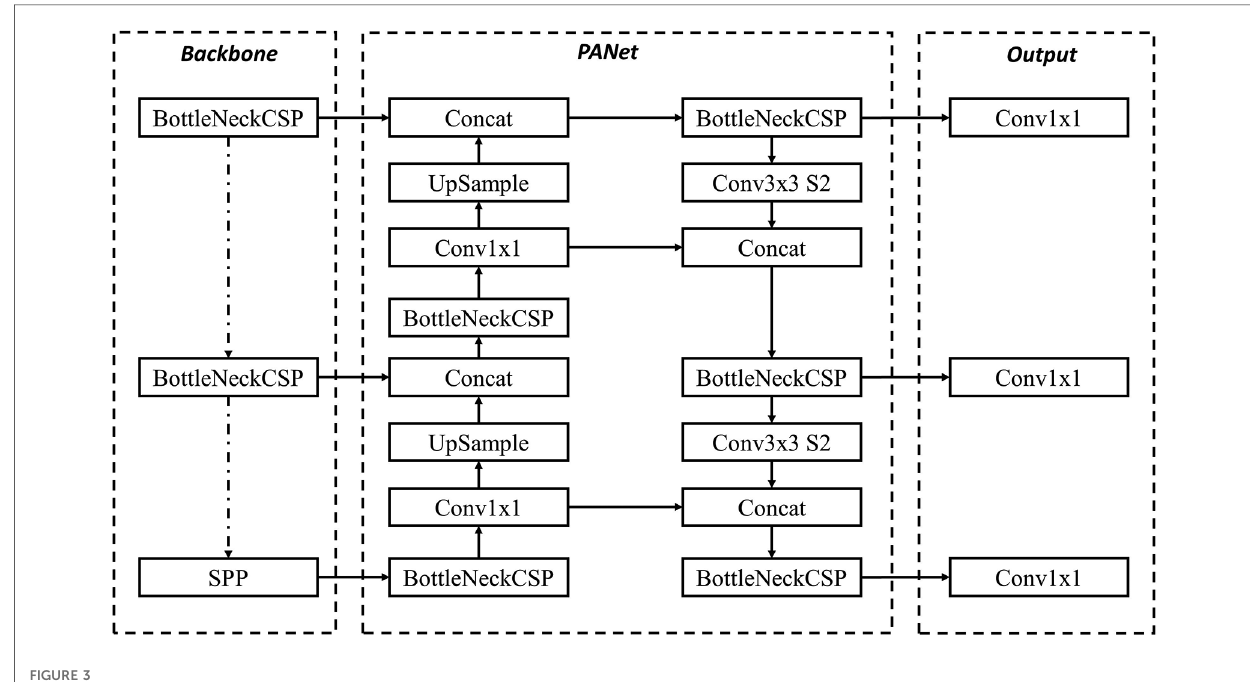
FIGURE 3 YOLOv5 architecture used for penile area cropping from still 2D